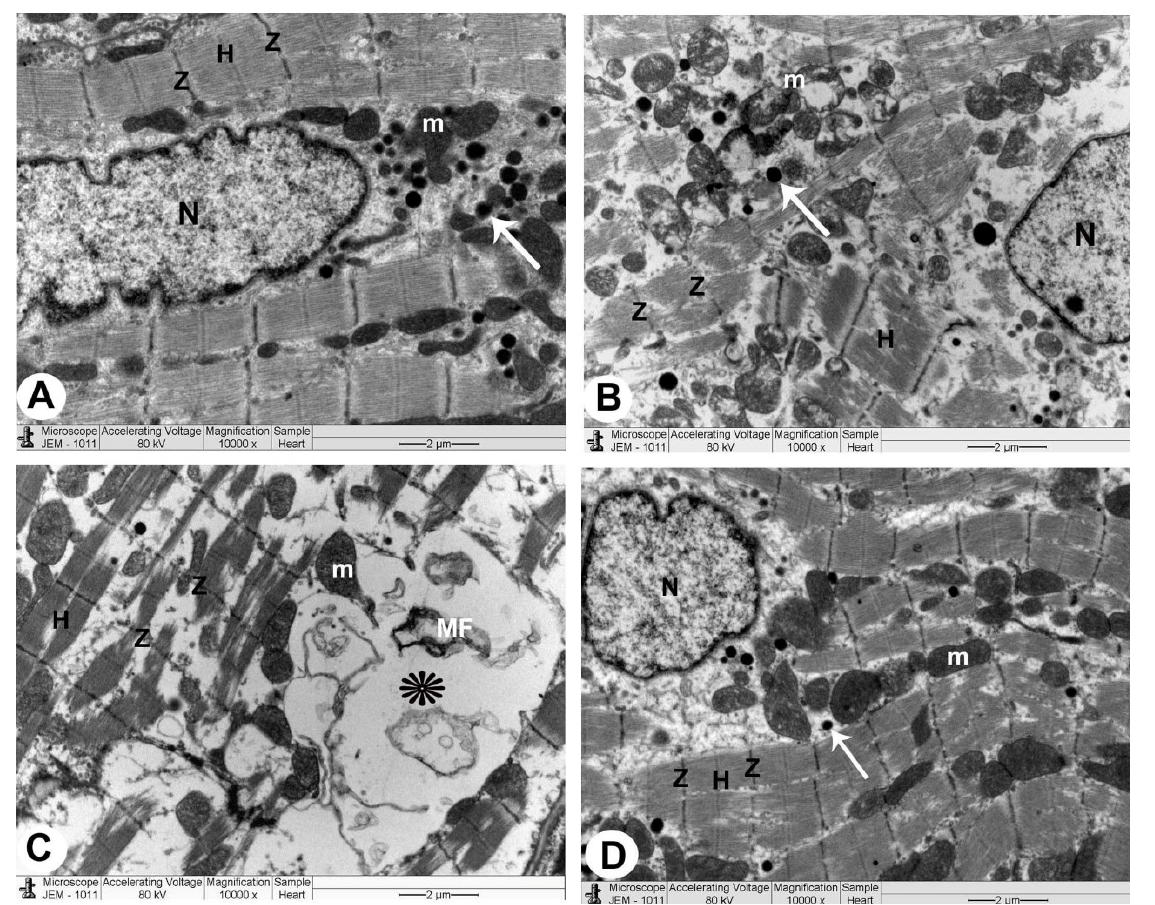
Figure 4. The right atrium is imaged using TEM in all groups of rats (atrionatriuretic factor (ANF) granules): (×10,000). ( A ) The control rat group has a normal myocyte structure with compact cytoplasm packed with the intact striped appearance of myofilaments (Z and H), a nucleus (N), and mitochondria (m). There are also granules of ANF that are tightly compacted (arrows). ( B , C ) QP-treated rat’s group exhibiting myofilament cytoplasm damage, muscle band fragmentation (Z and H), and pleomorphic mitochondria (m). There are also a few ANF granules (arrows) and abnormally shaped nuclei (N). In addition, damaged myelin figures (MF) can be detected in the cytoplasm (asterisk). ( D ) QP + Vit C-treated rat’s group revealing myofibrils with a striped appearance with distinct bands (Z and H), nucleus (N), and mitochondria which are all healthy (m). ANF granules (arrows) can also be seen.